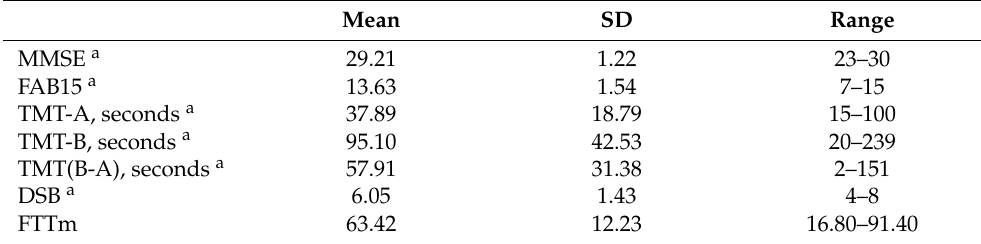
Table 1. Descriptive statistics of the neurocognitive measures employed. Mean